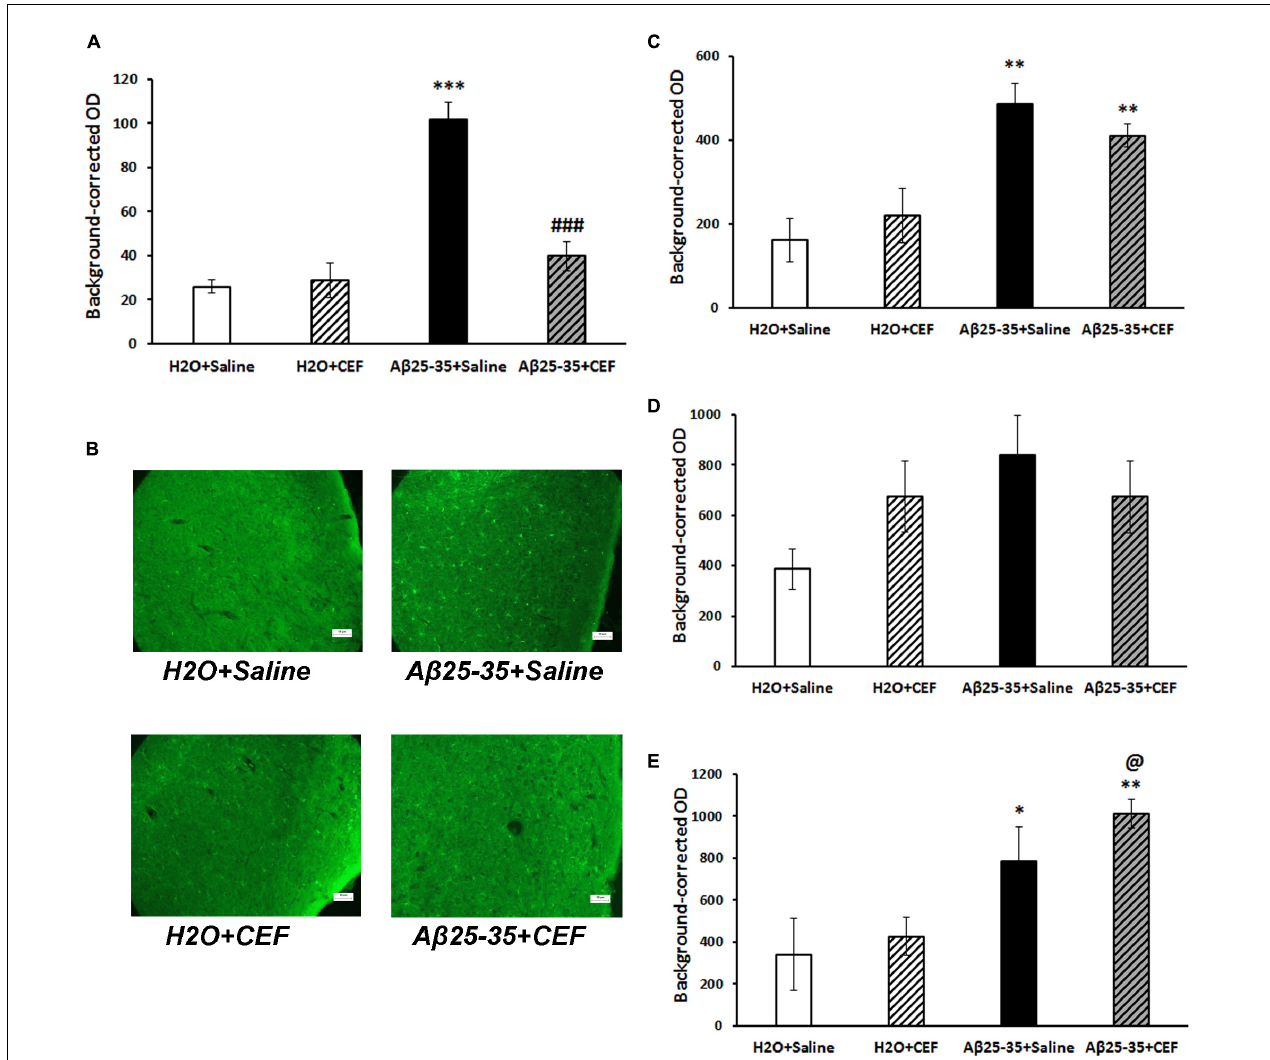
FIGURE 6 | Effects of the CEF and A β 25–35 administration (AD model) on the expression of microglial marker IBA1 in the frontal cortex (A,B) or hippocampus ( C in the CA1 area; D in the CA3 area; E in the dentate gyrus) in mice. (A,C–E) Quantitative results. The data are expressed as mean ± SEM of the values obtained in an independent group of animals ( n = 3–4 per group). Statistically significant differences: ∗ p < 0.05, ∗∗ p < 0.01, ∗∗∗ p < 0.001 vs. the “H 2 O + saline” group; ### p < 0.001 vs. the “A β + saline” group; @ p < 0.05 vs. the “H 2 O + CEF” group. (B) IBA1 immunoreactivity in the frontal cortex. Magnification, × 200; bar, 50 µ